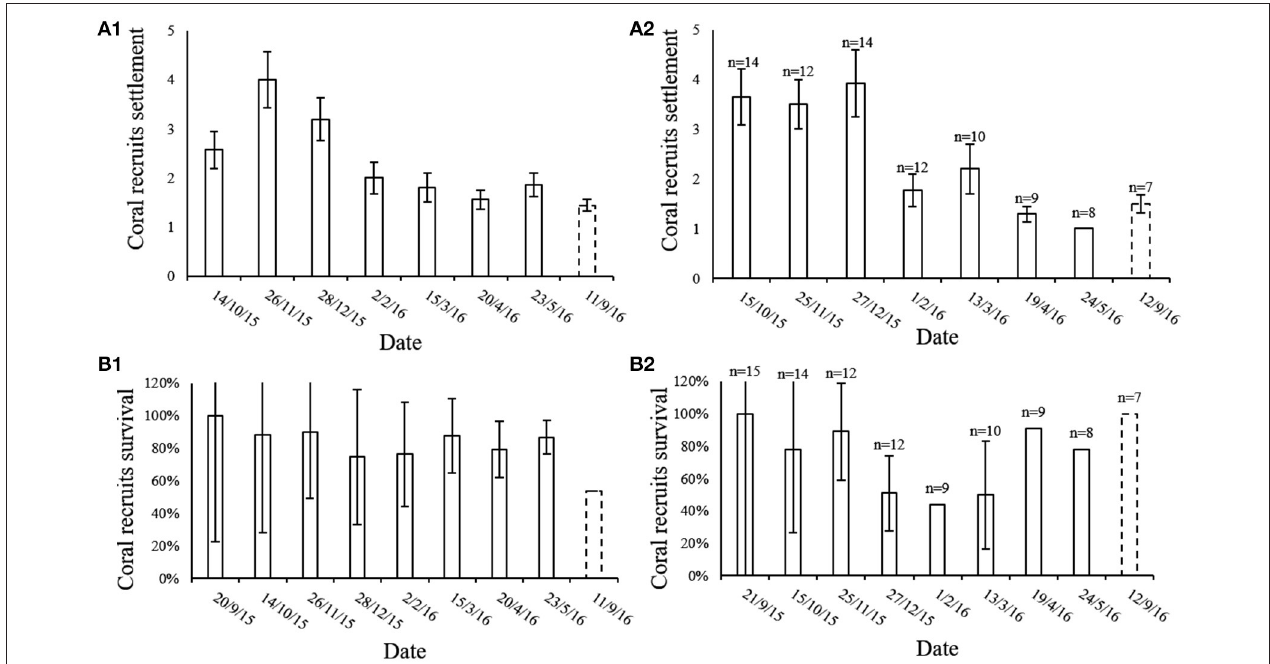
FIGURE 5 | (A) Mean number ( ± SE) of coral recruits settled in the 20 × 20cm quadrat during each month of our survey both in the (A1) MPA ( n = 18) and in the (A2) IUI sites. September 2015 is t = 0 and therefore not shown. (B) Percentage (mean ± SE) of coral recruits that survived their first month during the 8 month of survey at the reserve ( n = 18) (B1) and at the IUI (B2) . Since September 2015 is t = 0 we assume the survival for that month is 100%. Dashed line representing September 2016 emphasizes the 4 month gap from last survey and the return to the survey sites after 1 year.